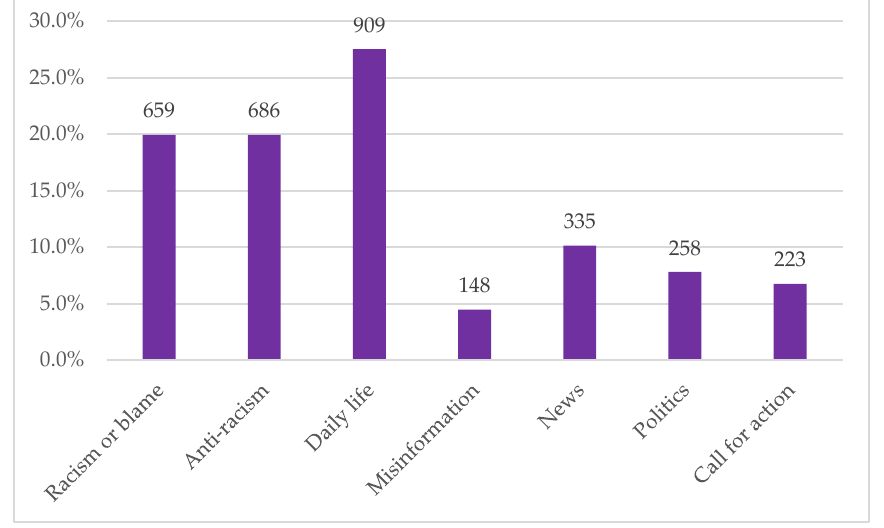
Figure 2. Percent and number of tweets in each content analysis category. Table 4. Content analysis of themes with illustrative examples.